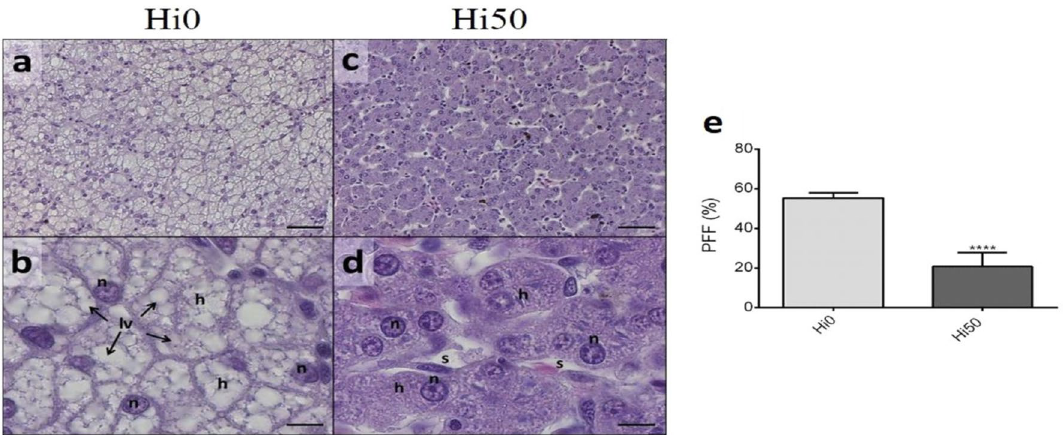
Figure 3. Example of liver histomorphology and percentage of fat fraction (PFF) in hepatic tissue of Siberian sturgeon at t 1 . ( a , b ) Hi0; ( c , d ) Hi50; ( e ) PFF. Histology scale bars: ( a , c ) 50 μm; ( b , d ) 10 μm. Letters: h hepatocyte, n nucleus, lv lipid vesicles, s hepatic sinusoids. For PFF, values are shown as percentage mean ± SD (n = 15). Significant differences between Hi0 and Hi50 are indicated as follows: ns, non-significant; *p < 0.05; **p < 0.01; ***p < 0.001 and ****p < 0.0001. Sturgeon fed diets including 0 and 50 of BSF meal (Hi0 and Hi50, Hi50, respectively) and n9 (19.9 ± 0.1 and 19.9 ± 0.5% for Hi0 and Hi50, respectively) content. However, the Hi50 group was characterized by a significantly (p < 0.0001) lower n3 percentage (24.9 ± 1.2%) and a significantly